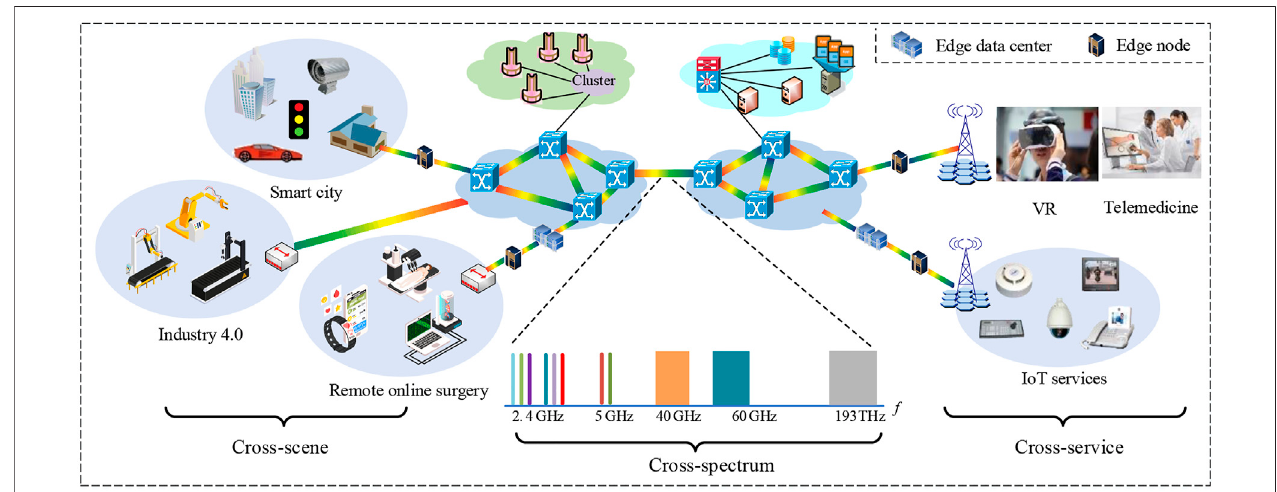
FIGURE 1 | 3-CS edge optical network